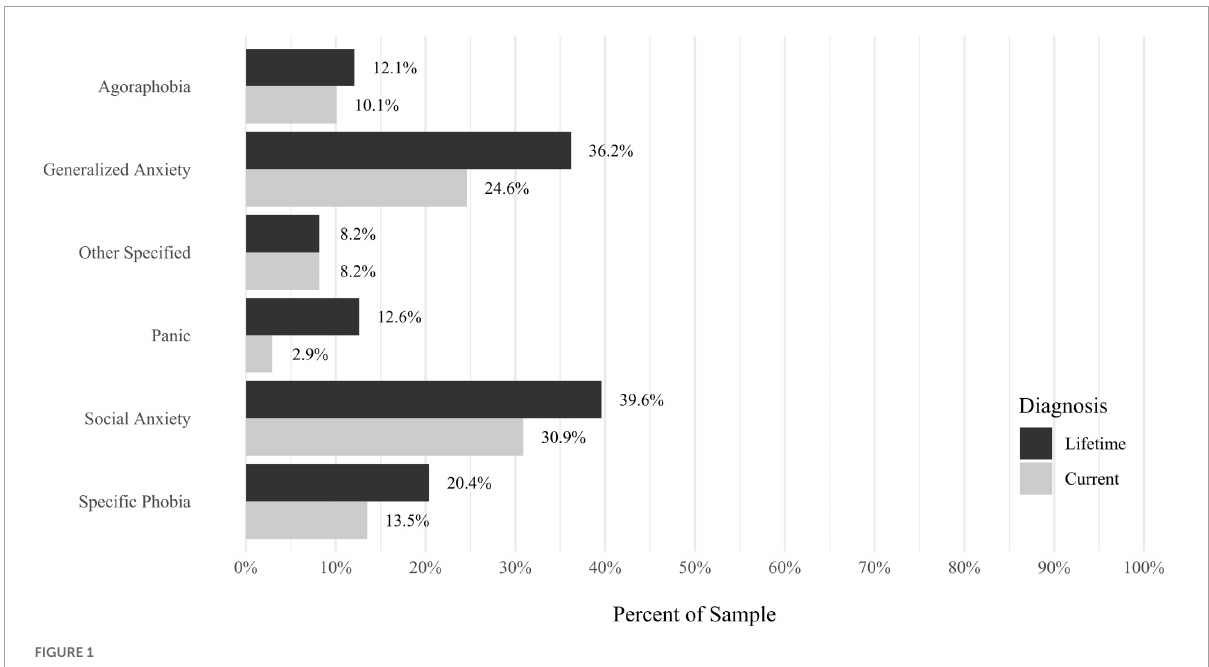
FIGURE1 Rates of psychiatric disorders: anxiety